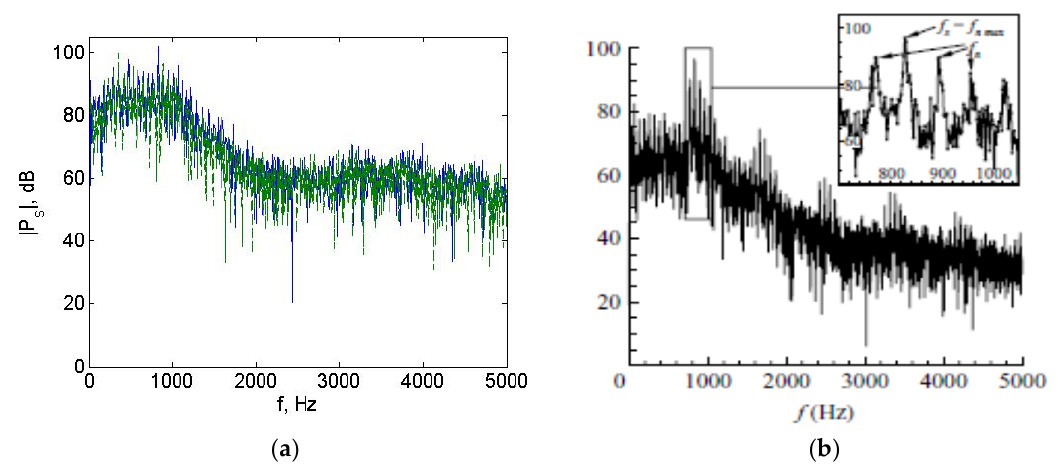
Figure 11. Near-field sound pressure spectra, comparison of [14] ( a ) and [16] ( b ). (Adapted from [14]).